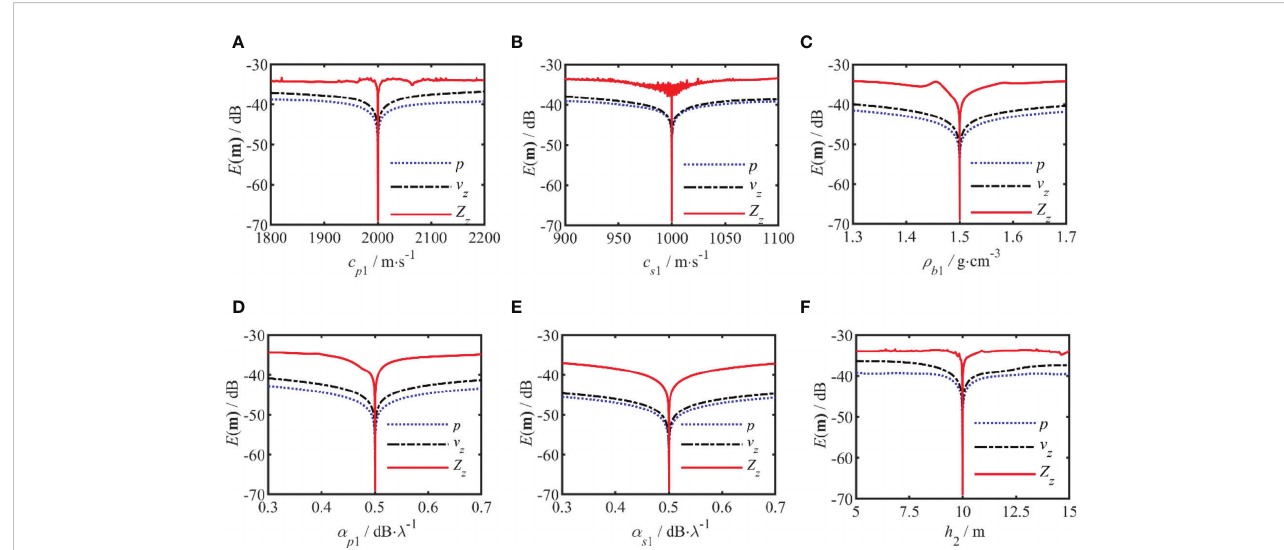
FIGURE 3 The sensitivity analysis of the error function E ( m )) for the geoacoustic parameters of the sedimentary layers. (A – F) corresponds to the c p 1 , c s 1 , r b 1 , a p 1 , h a s 1 , and 2 , respectively. The red curve represents is for the vertical waveguide characteristic impedance, and the black curve represents the vertical particle velocity and blue curve is for the acoustic